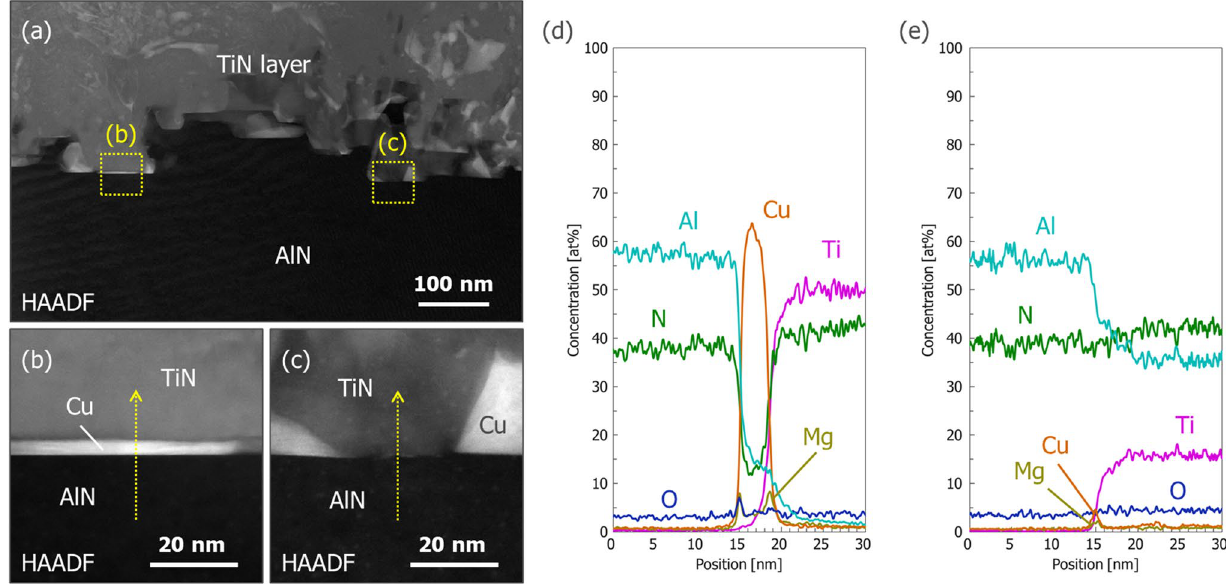
Fig. 11 a – c Cross-sectional HAADF images of a TiN layer/AlN interface bonded at 950 ℃ for 0.5 h. w Mg and w Ti were 1.04 mg/cm 2 and 0.45 mg/cm 2 , respectively. Line EDS profiles of d TiN/AlN indirect interface and e TiN/AlN direct interface. The yellow dotted arrow shown in ( b , c ) corresponds to the position from which the line EDS profiles in ( d , e ) were